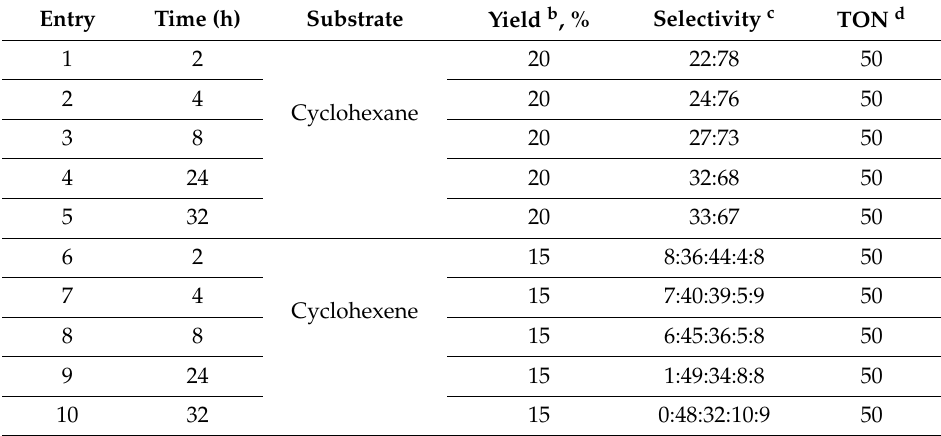
Table 6. Scope of the peroxidative hydrocarbon oxidation employing catalyst 3 a